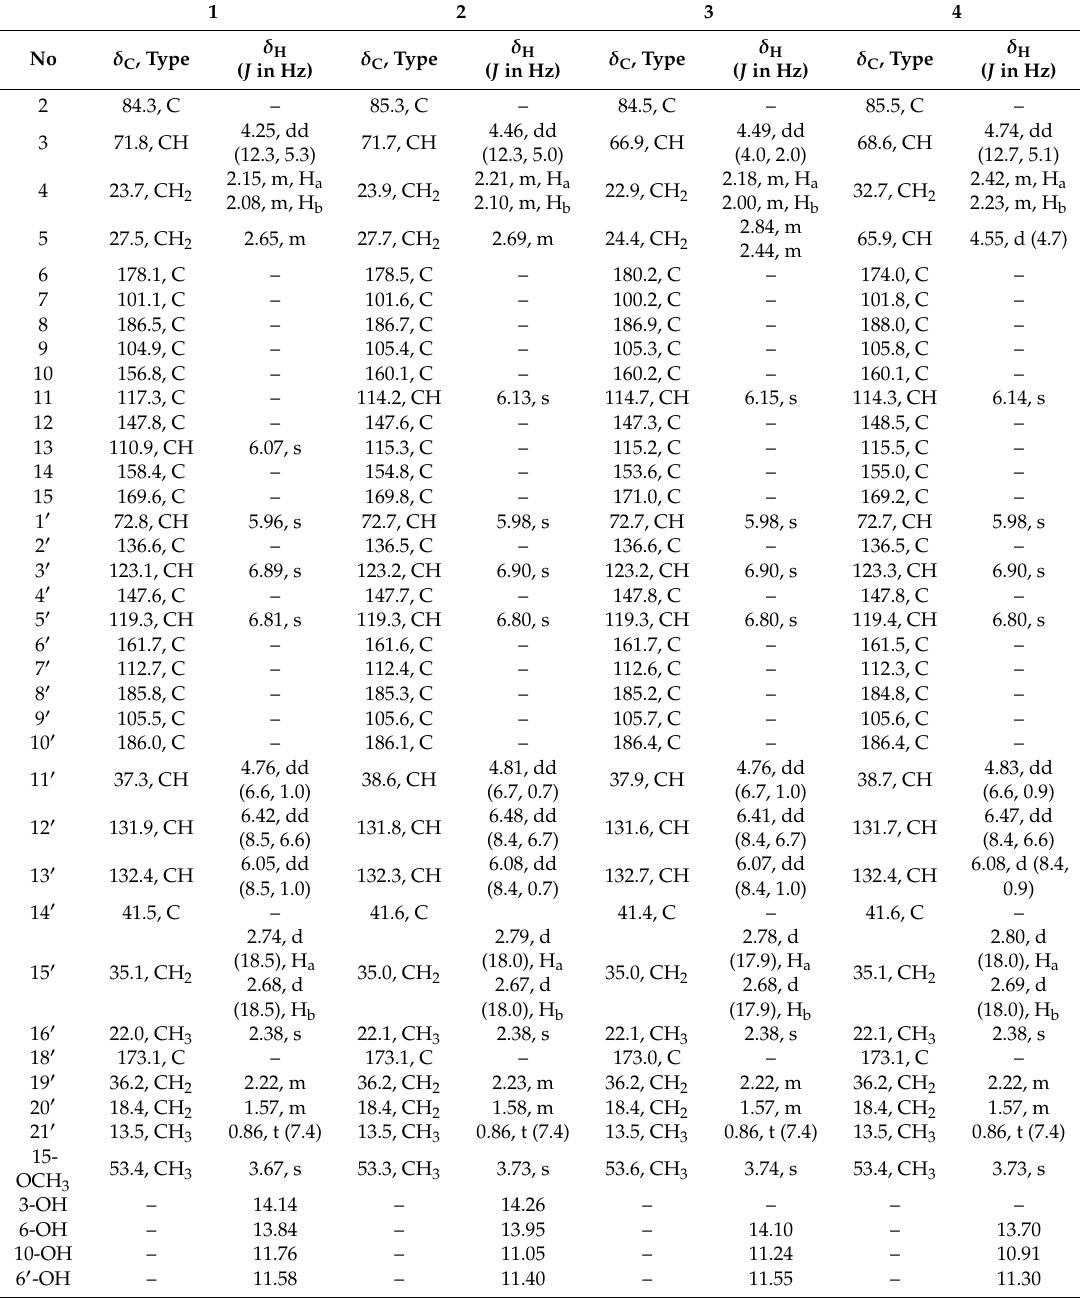
Table 1. One-dimensional nuclear magnetic resonance (1D-NMR) spectroscopic data for compounds 1 – 4 (in CDCl 3